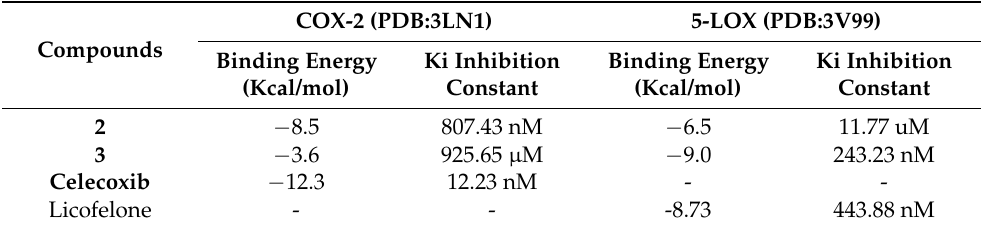
Table 1. The docking result for COX-2 and 5-LOX.